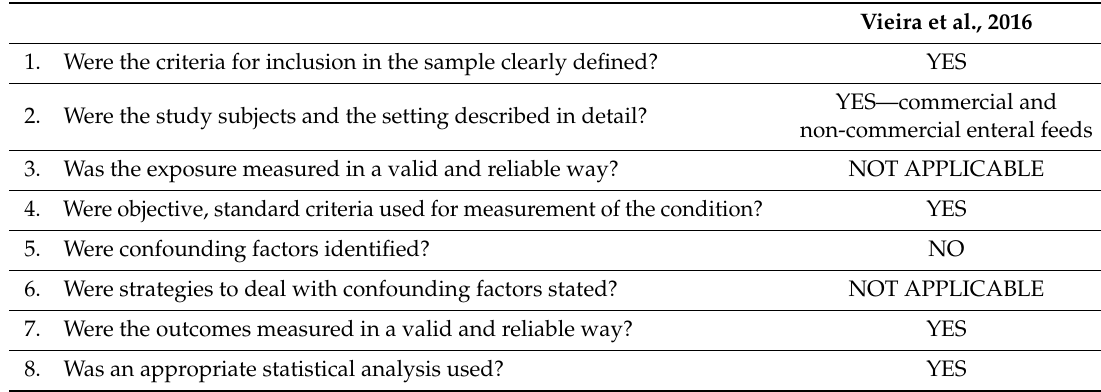
Table A1. Joanna Briggs Institute Critical Analysis Tool for Cross-sectional Studies.